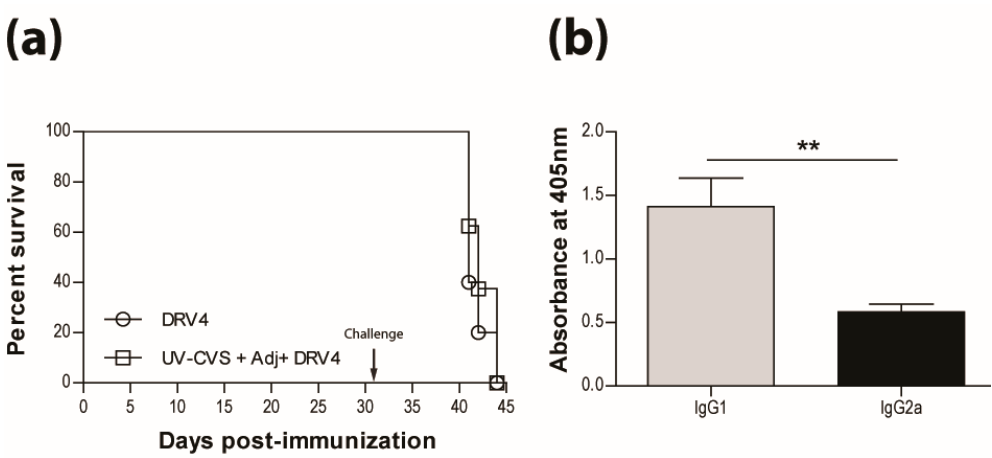
Figure 3. Adding adjuvant to UV-inactivated RABV does not induce protection. ( a ) C57BL/6 mice were immunized with 5 × 10 7 f.f.u. of UV-CVS-F3 mixed with CFA adjuvant, i.m.g. then challenged 31 days later with 1 × 10 5 f.f.u. of DRV4 i.n. and monitored for survival. Data are expressed as percent survival. ( b ) Virus-specific Ab isotyping was determined by ELISA 24 days post-immunization. Results are expressed as mean absorbance ± SEM in OD (dilution 1:50). Statistically significant differences between groups (n = 10 per group) are denoted as follows: ** p ≤ 0.005.